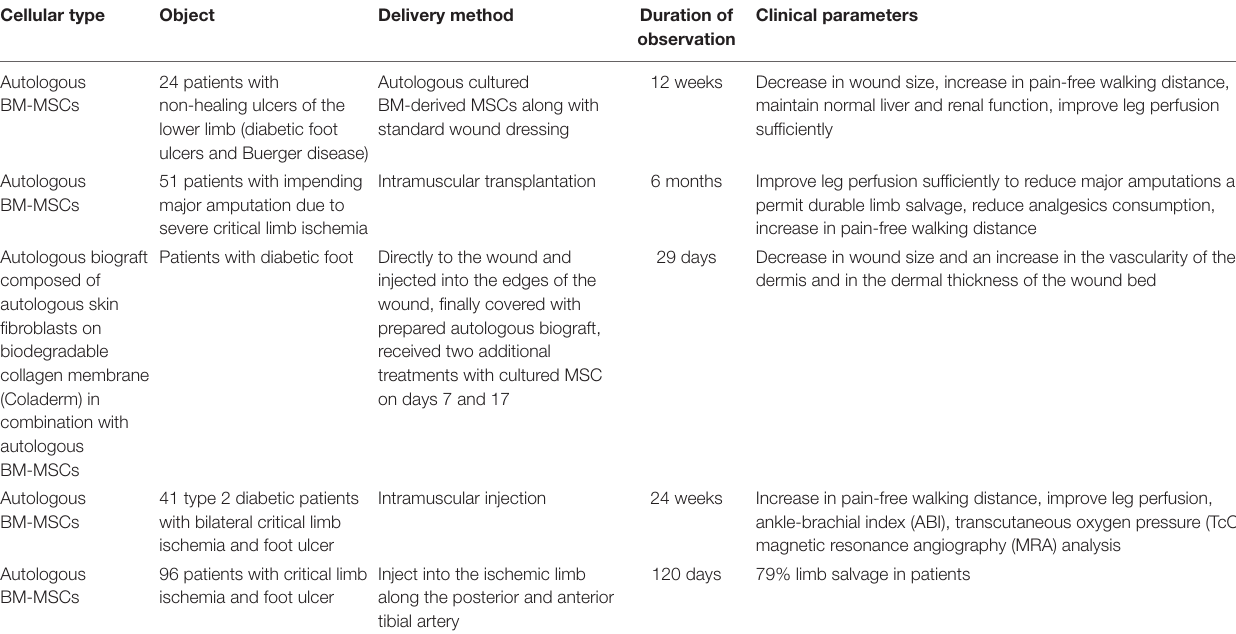
TABLE 1 | Clinical trials of BM-MSCs in